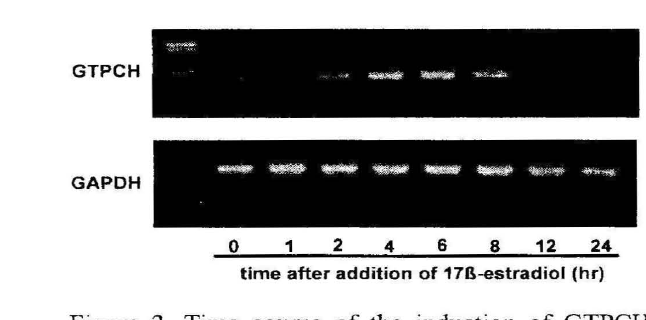
Figure 2. Time course of the induction of GTPCH mRNA by 1713-estradiol in mouse brain microvascular endothelial cells. Cells were incubated with 1713-estra diol (30 11M) for various periods, followed by extrac tion of total RNA from the cells. Total RNA (0.2 Ilg) was amplified by RT-PCR using primers for GTPCH or GAPDH. DNA size markers in the left-most lane correspond to (bp) : 525, 500,400, 300.